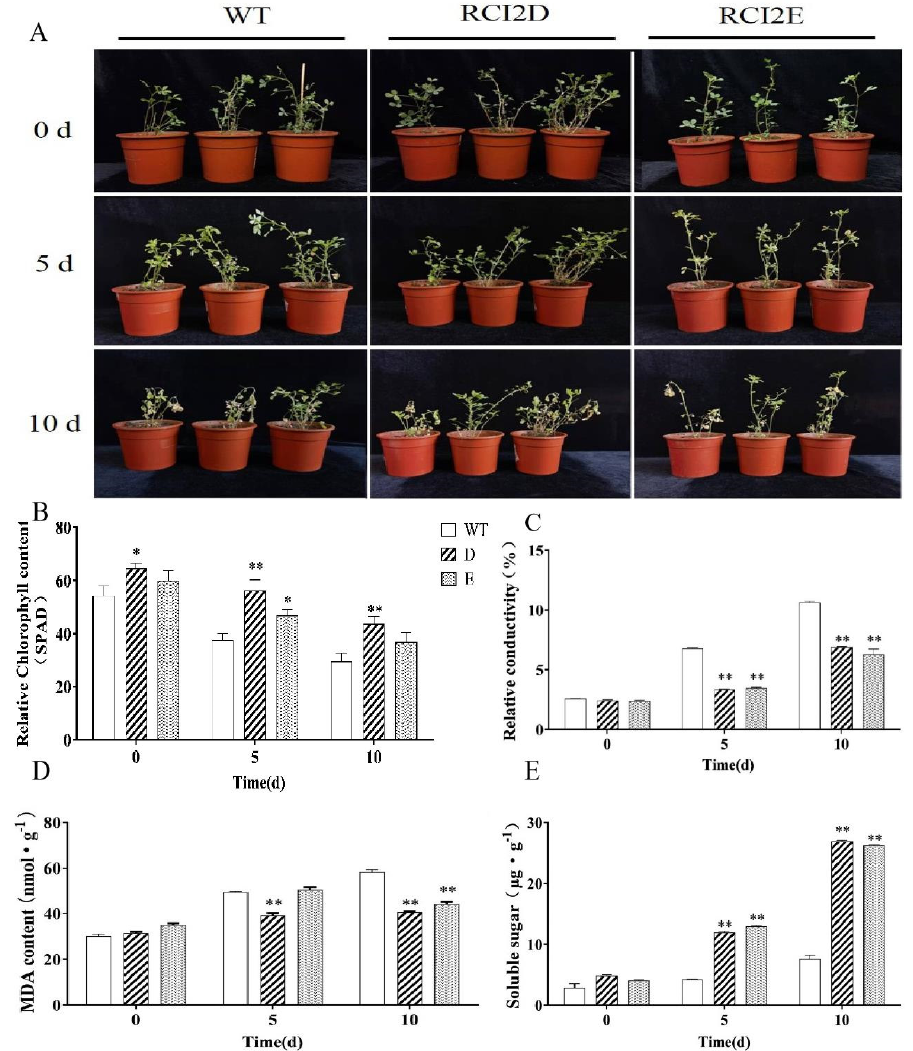
Figure 4. Phenotype ( A ), chlorophyll content ( B ), relative conductivity ( C ), malondialdehyde con- tent ( D ), and soluble sugars ( E ) analysis of alfalfa transformed with the MsRCI2D and MsRCI2E genes on the 5th and 10th days of salt treatment. WT stands for wild type. RCI2D and RCI2E were transformed with the MsRCI2D and MsRCI2C genes in hairy roots, respectively. The values are the means ± SDs of three replicates; * indicates a significant difference ( p < 0.05); ** indicates an extremely significant difference ( p < 0.01).